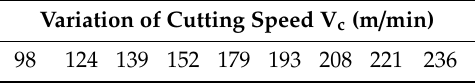
Table 1. Parameters for the experimental plan.